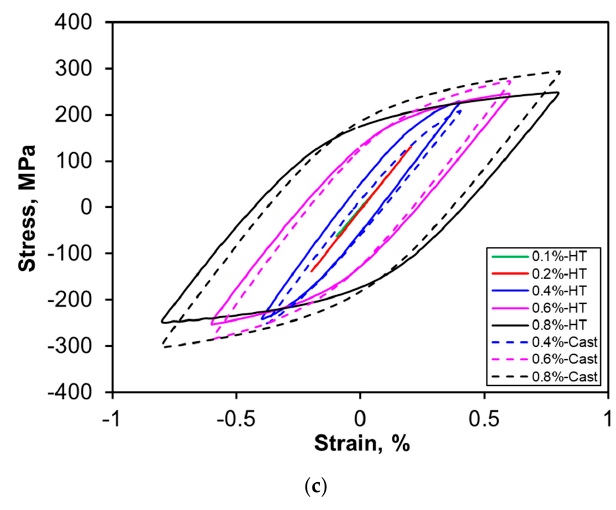
Figure 7. Typical hysteresis loops of the alloy in the as-cast and heat-treated states at various total strain amplitudes for the ( a ) first, ( b ) second, and ( c ) mid-life cycles. Furthermore, serrated flow was also observed to appear in the plastic regime in the compressive phase at the strain amplitudes of 0.4% and beyond. A couple of serrations at irregular intervals were also observed in the initial tensile phase at total strain amplitudes from 0.4% to 0.8%, as shown in Figure 7a. This is in agreement with the observation of serrated flow, resulting from DSA, during the monotonic tensile test of the heat-treated alloy subjected to much higher level of straining. During LCF, the serrations were basically observed in the initial (first and second) cycles, then gradually